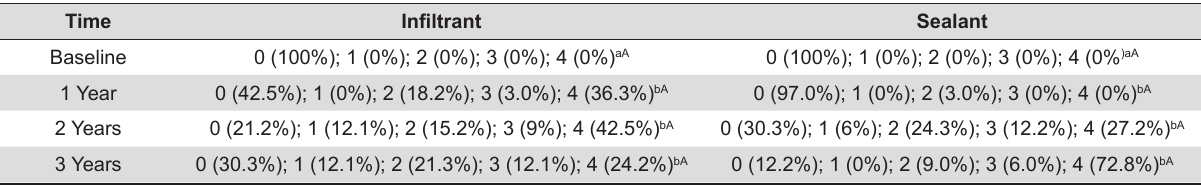
Table 3- Percentual distribution (%) of sealing marginal